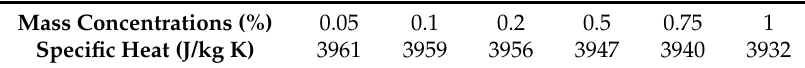
Table 5. The specific heat of silica nanofluid.